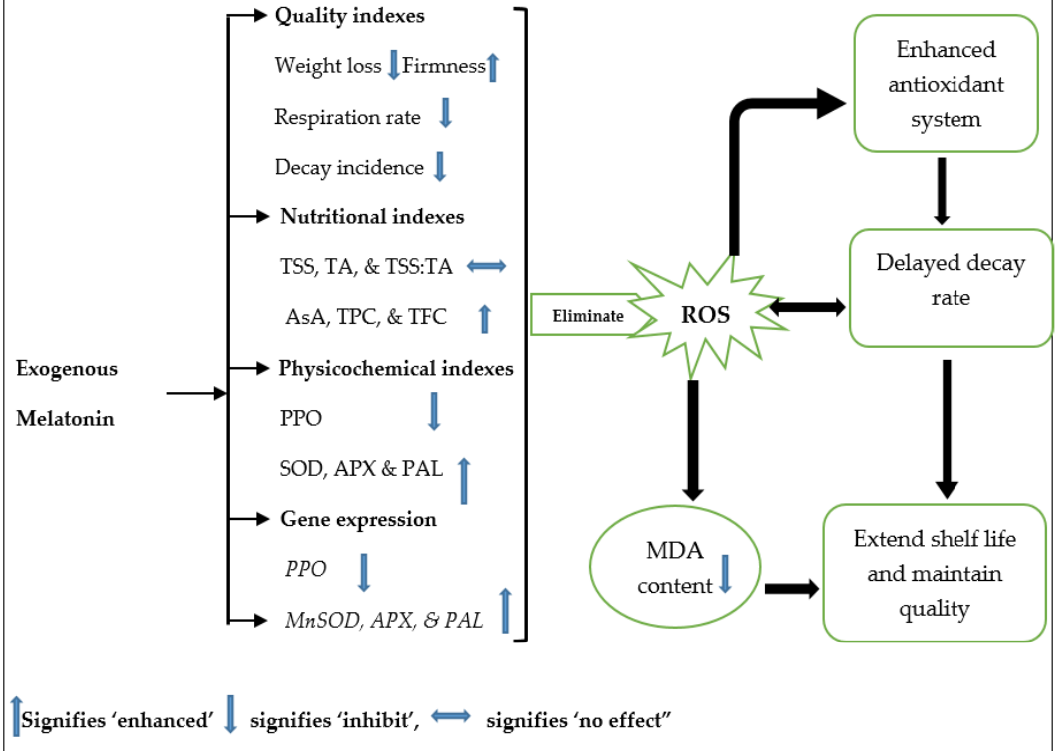
Figure 11. Schematic representation of melatonin (MT) antioxidant system enhancement. MT maintains the increase in weight loss, respiration rate, and decay and maintains the decrease in firmness. MT does not affect TSS, TA, and TS:TA. MT eliminates ROS directly and inhibits MDA content. It also increases the levels of PAL enzyme activity, enzymatic antioxidants (SOD, APX), and non-enzymatic antioxidants (AsA, TFC, TPC) and minimizes the activity of the PPO enzyme. MT enhanced the expression of genes related to the antioxidant system ( MnSOD and APX ) and the PAL gene and inhibited PPO relative gene expression. Abbreviations: TSS, total soluble solids; TA, titratable acidity; AsA, ascorbic acid content; TPC, total phenol content; TFC, total flavonoid content; PPO, polyphenol oxidase; SOD, superoxide dismutase; APX, ascorbate peroxidase; and PAL, phenylalanine ammonia-lyase.